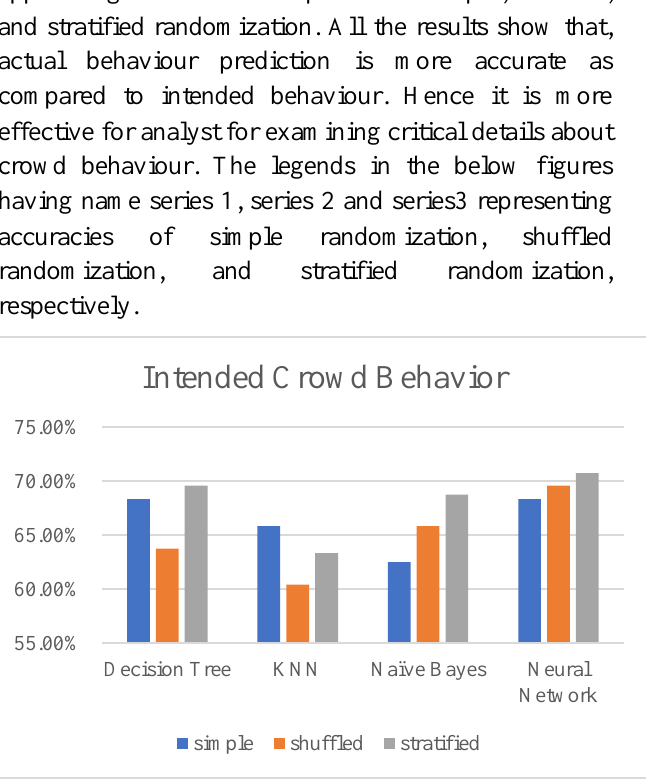
Fig. 3. Overall accuracy for intended crowd behaviour